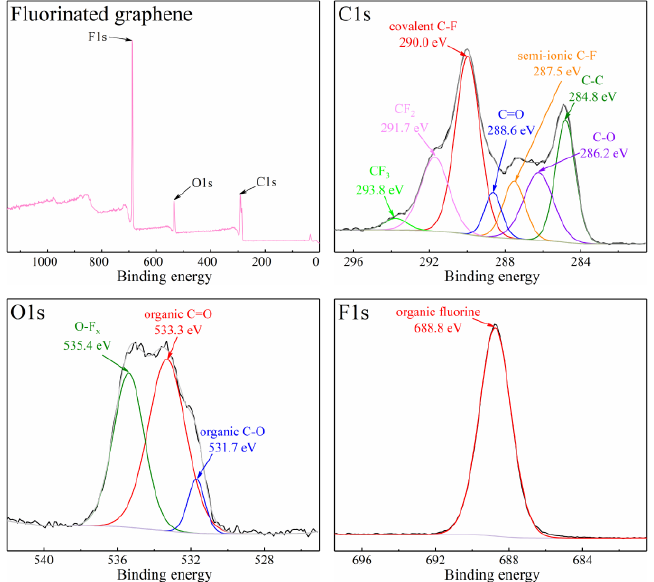
Figure 4. The XPS spectra of C1s, O1s and F1s for the fluorinated graphene sample. The black line is the original data and the grey line is the fitting